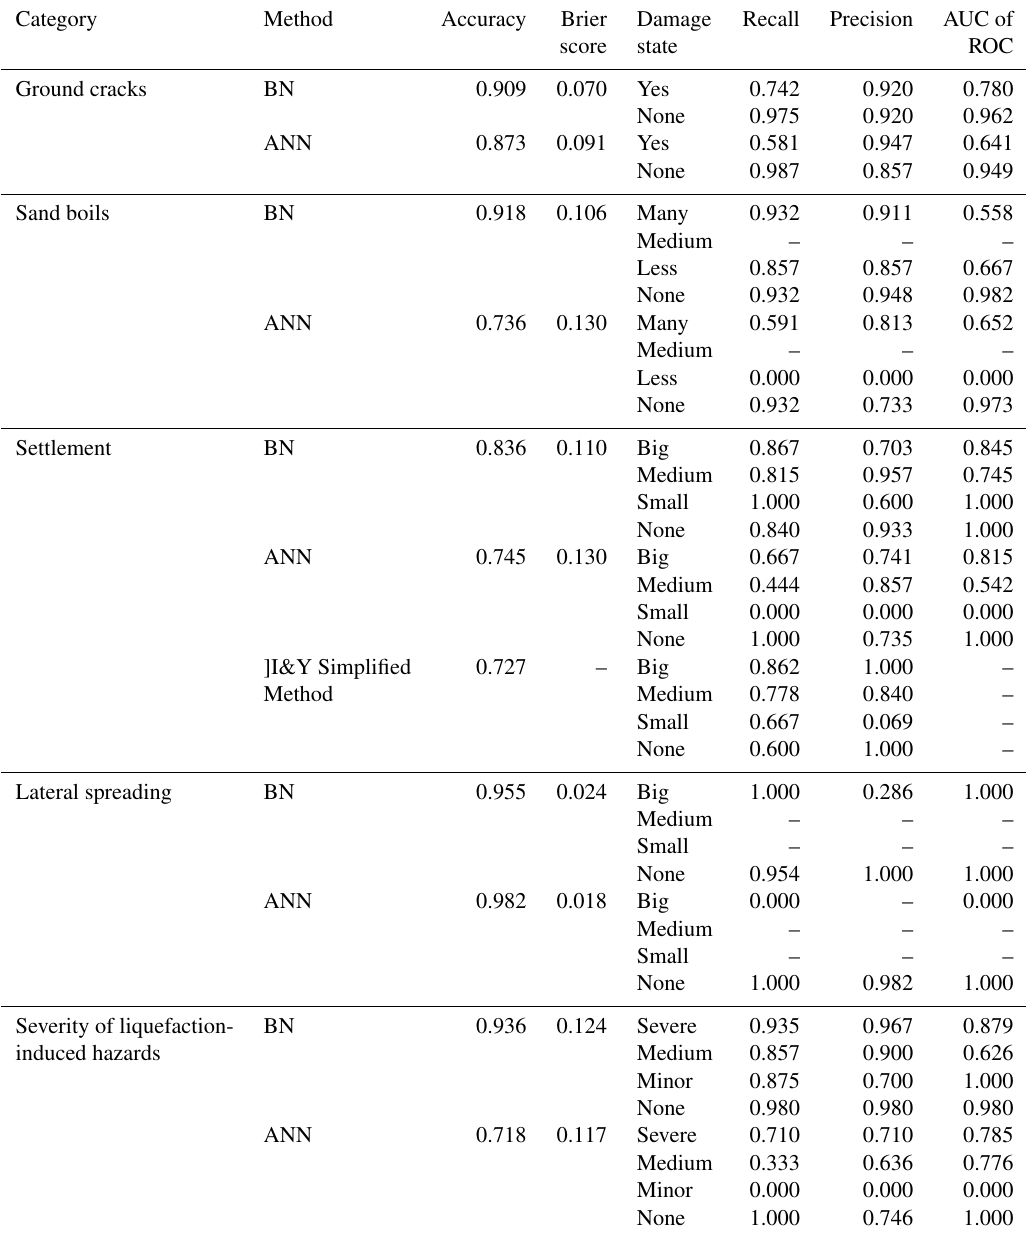
Table 5. Comparison of predictive performance of liquefaction-induced hazards. Category Method Accuracy Ground cracks